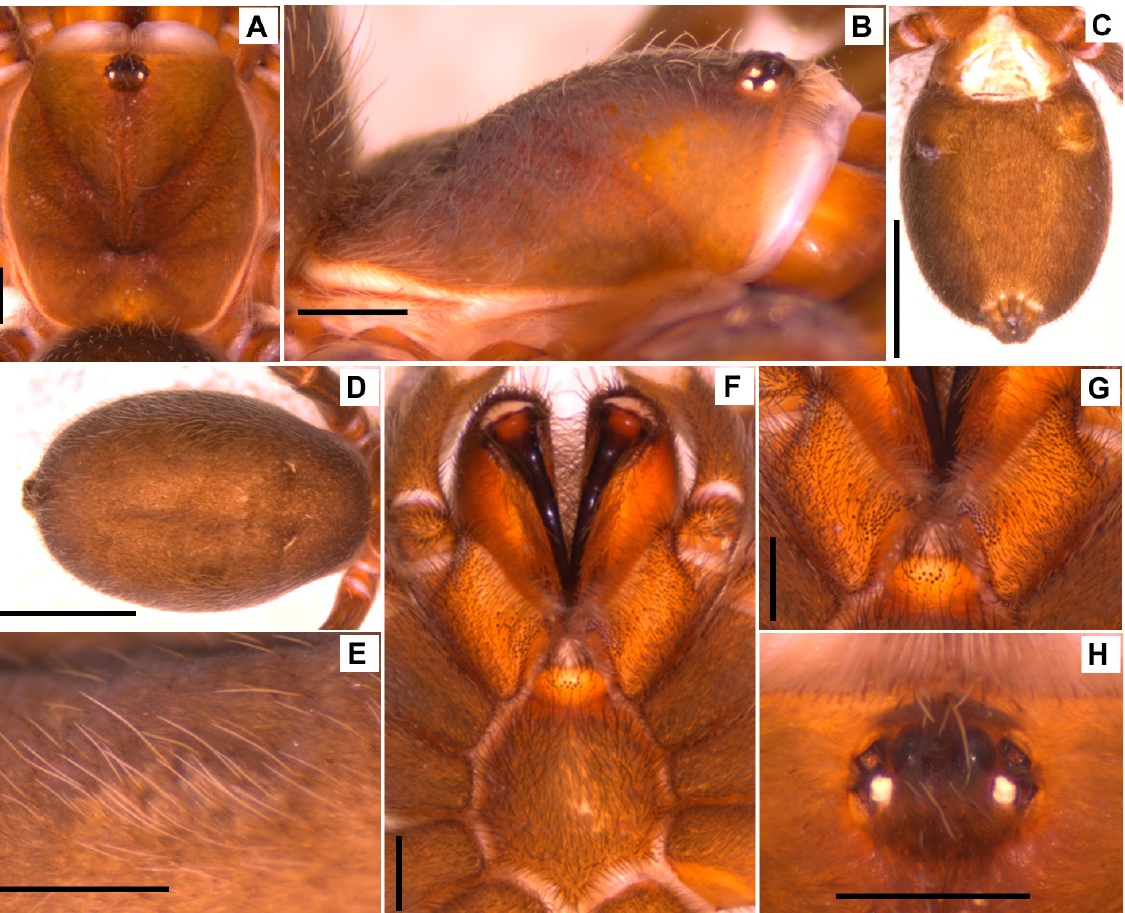
Fig. 12. Bistriopelma kiwicha sp. nov., paratype, ♀ (MUBI 41). A . Carapace, dorsal view. B . Carapace, lateral view. C . Abdomen, ventral view. D . Abdomen, dorsal view. E . Urticating setae patch. F . Sternum, labium and maxillae, ventral view. G . Labium and maxillae, ventral view. H . Eyes. Scale bars = 1